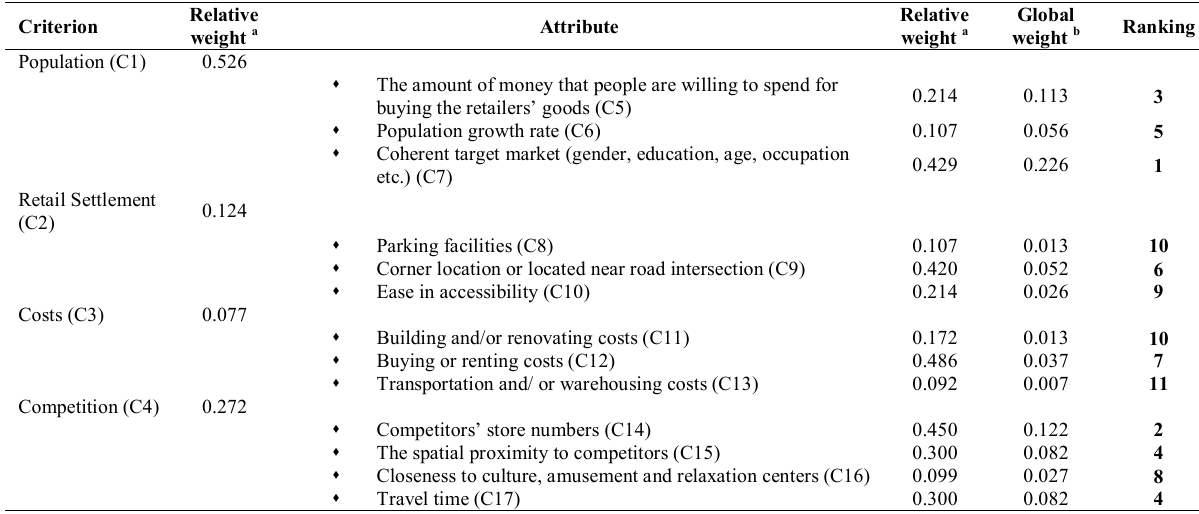
Table 4: Relative and global weights for each criterion and attribute in store location